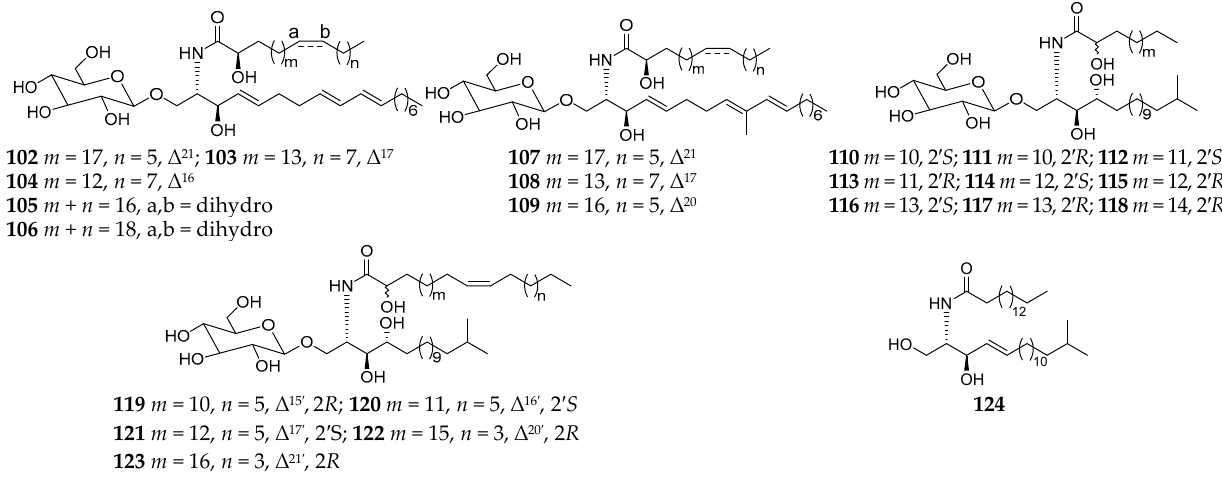
Figure 10. Cerebrosides 102 – 123 and ceramide 124 from the subgenus Reniera.